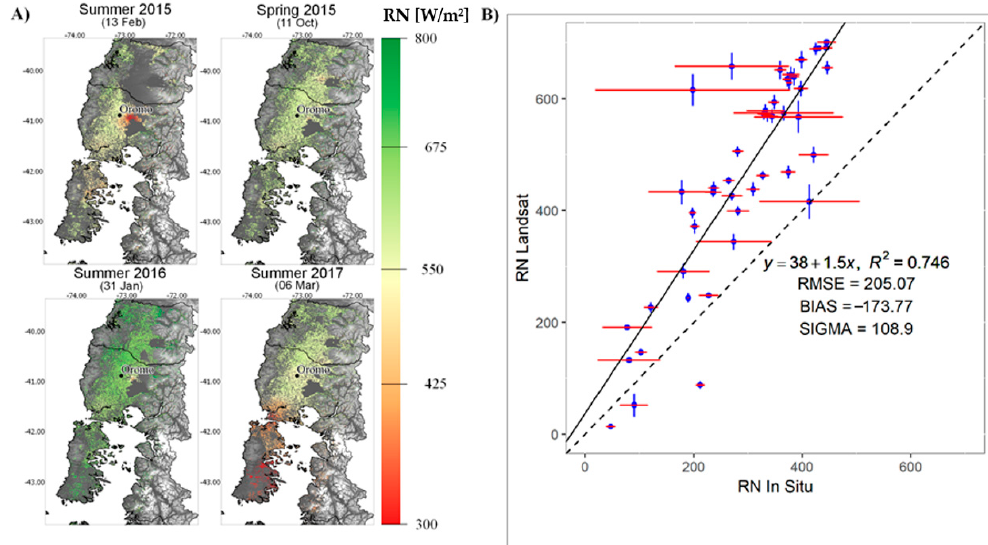
Figure 3. Estimates of net radiation and comparison with local measurements. ( a ) Satellite-based estimates of instantaneous net radiation [W m − 2 ] in pastures during selected spring and summer days. Note that the images correspond to the same dates than those shown in Figure 3 for surface temperature. ( b ) Local comparison against in-situ measurements at the Oromo calibration